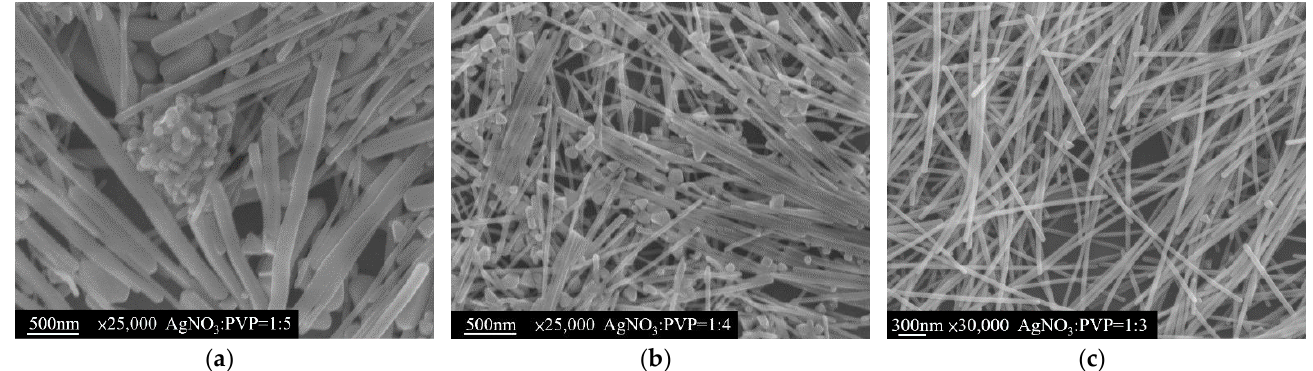
Figure 3. FE-SEM images of different reaction ratios AgNWs. AgNO 3 :PVP = ( a ) 1:5, ( b ) 1:4, ( c ) 1:3.